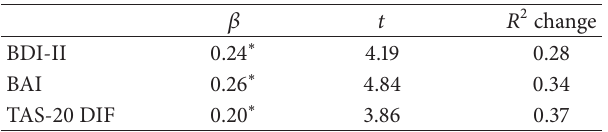
Table 4: Main and interaction effects of BDI-II, BAI, and TAS-20 on the OCI-R subscales ( 𝑛 =